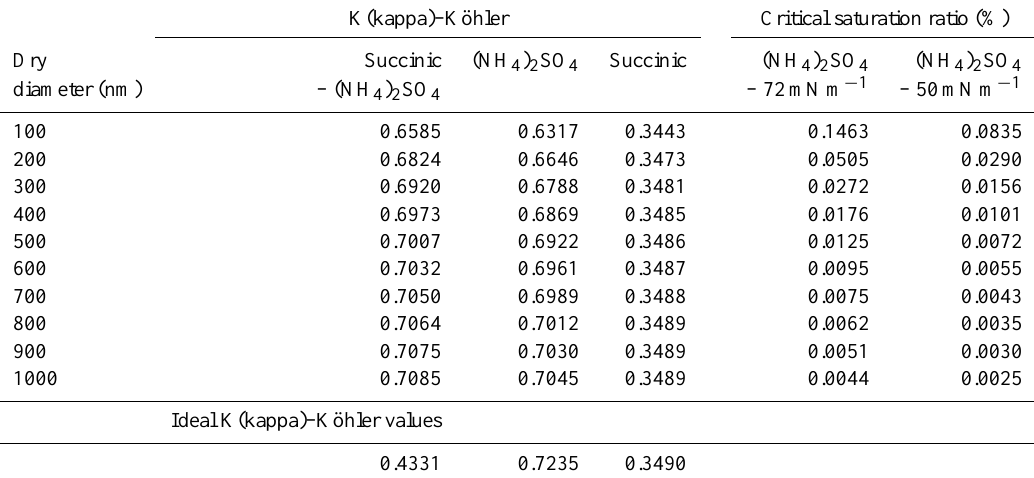
Table 6. Predicted K(kappa)–Köhler values, with and without accounting for solution non-ideality, derived from the predicted critical point for an equimolar succinic acid – (NH 4 ) 2 SO 4 aerosol, and the two separate components, setting the surface tension to 72mNm − 1 as a function of dry